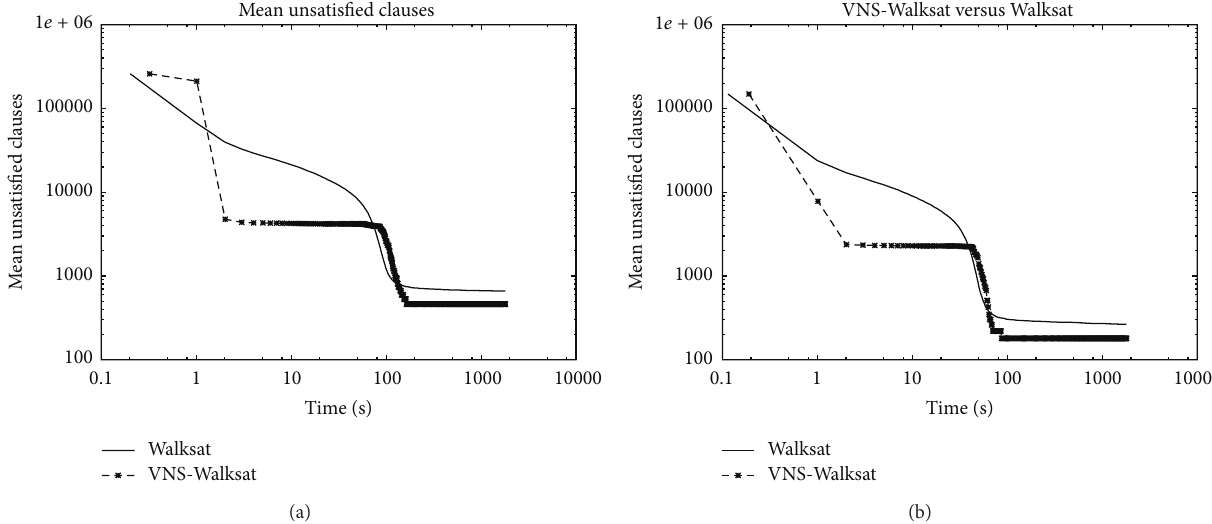
Figure 3: Log-Log Plot: (a) rsdecoder2.dimacs.filtered.cnf: variables = 415480, clauses = 1632526, (b) rsdecoder-fsm1.dimacs.filtered.cnf: variables = 238290, clauses = 936006. Time development for 100 runs in 15 minutes.